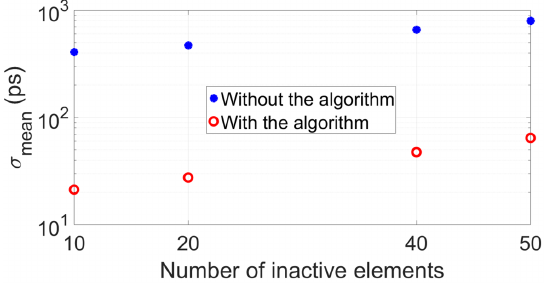
Figure 6. Mean value of the distributions of standard deviation shown in Figure 5b, which were obtained from simulation